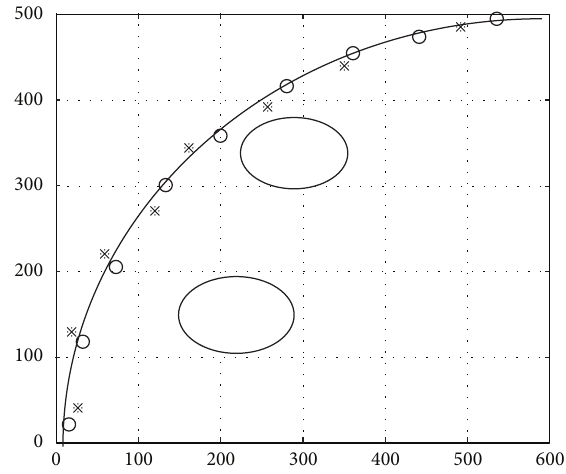
Figure 2: Multi-UAV formation autonomous reconfiguration tra-